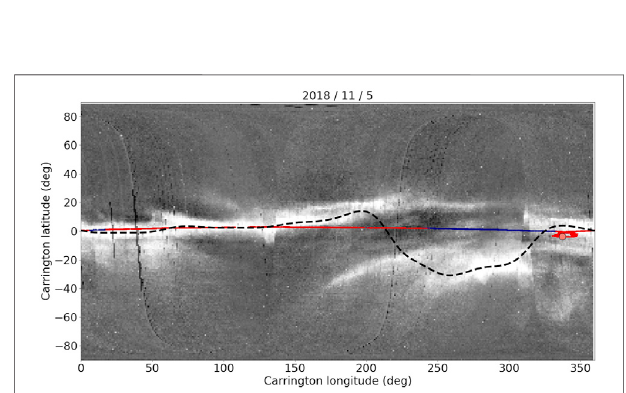
FIGURE 7 | History of magnetic polarities measured in situ at PSP from 21-10-2018 to 04-12-2018. In the background a WL synoptic map from LASCO C2 at 5 . 0 R ⊙ and the SMB line as a dark dashed line are shown. A dynamic update of this fi gure over time is available in the online material, where the thick dot highlights the current in situ measurement on top of the past and future track. Positive (and negative) polarities are represented in blue (and red)